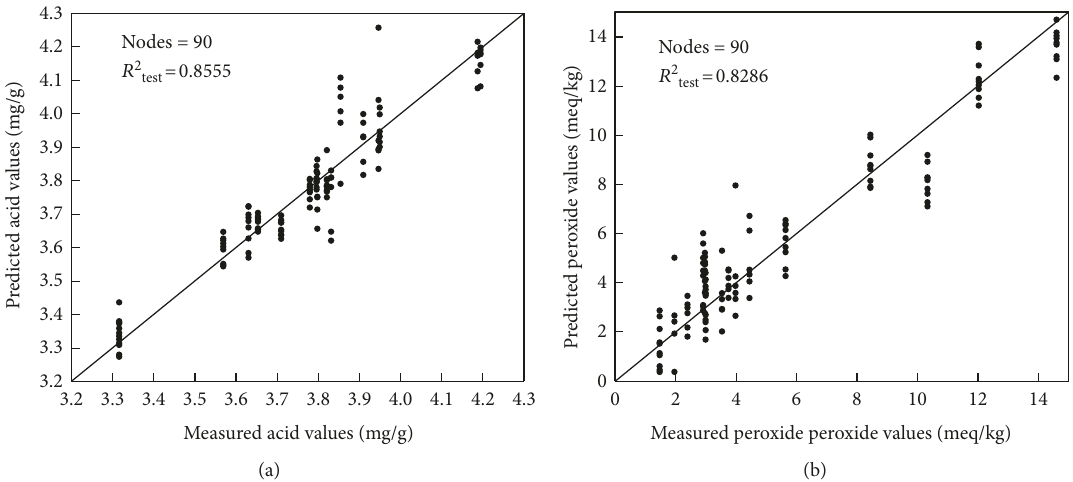
Figure 7: Graphs of the best results for the prediction of acid and peroxide values (90 nodes). (a) Acid value. (b) Peroxide and it was determined that the prediction results for ANN models for both the acid value ( R 2 : 0.9037, R 2 : 0.8175, tra val and R 2 : 0.8555) and peroxide value ( R 2 : 0.9210, R 2 : test tra val 0.9341, and R 2 : 0.8286) were the highest among the devel- test oped models.